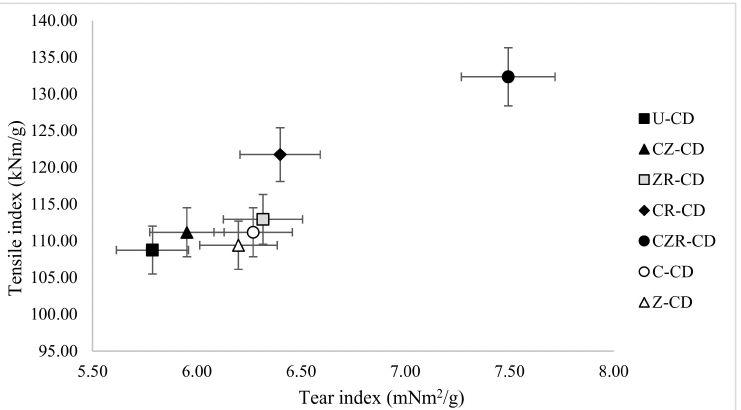
Figure 4. Tensile and tear indices for the uncoated (U), chitosan and zein coated (CZ), blend zein and rosemary oil coated (ZR), blend chitosan and rosemary oil coated (CR), chitosan, blend zein and rosemary oil coated (CZR) paper, pure chitosan in one layer coated (C) and the pure zein in one layer coated (Z) paper in the CD